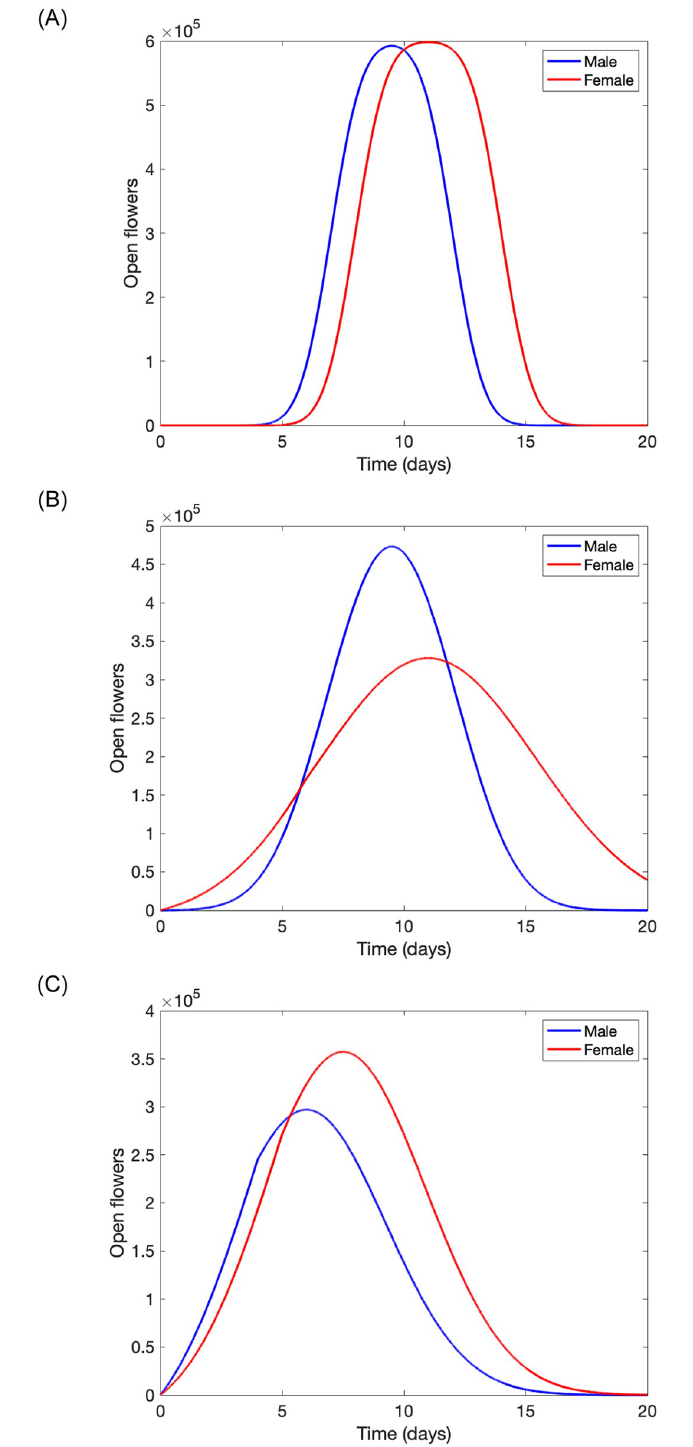
Fig 1. Example simulations of open flowers over time following Eq (2) starting with 600,000 of each male and female flower buds B m = B f = 600, 000 (representing a one ha. of the orchard) for (a) σ m = 1, σ f = 1, t m = 7, t f = 8, τ m = 5, τ = 6 and (b) σ f